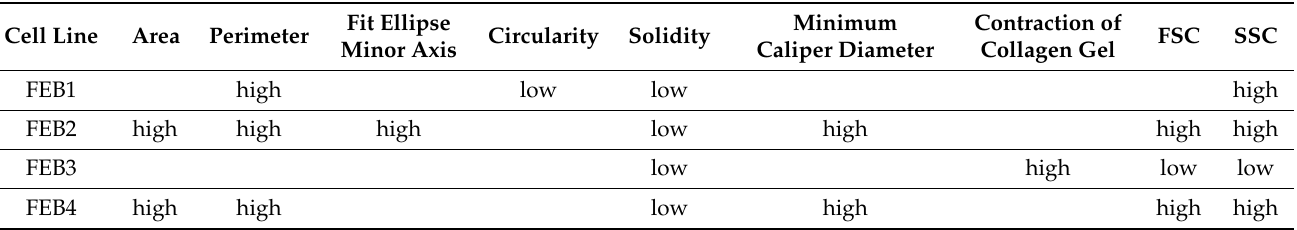
Table 2. Morphology analysis of individual FEB lines compared to